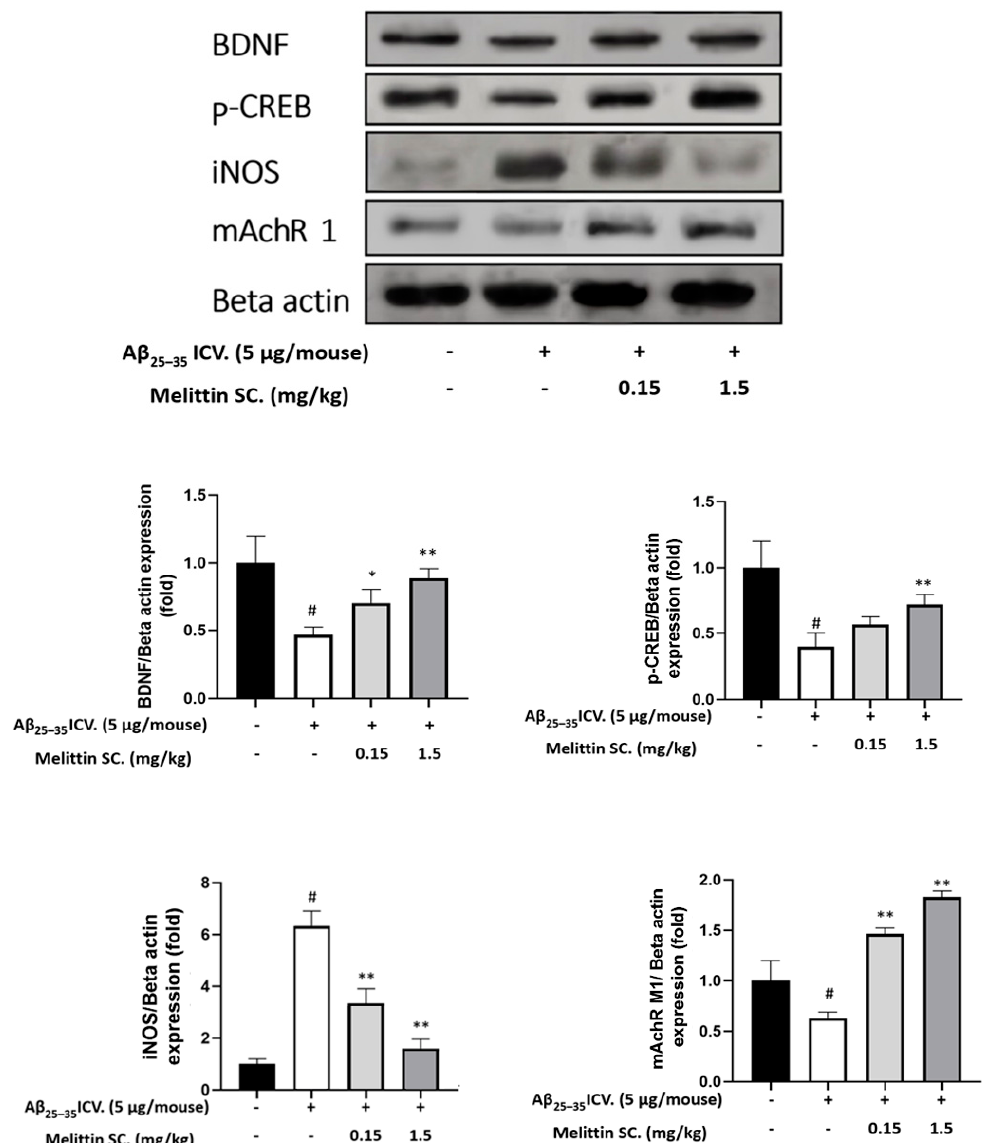
Figure 9. Levels of BDNF, p-CREB, iNOS, and mAchR1 protein expression in the mouse hippocampus show the dose- dependent protective effect of melittin against A β 25–35 -induced neuro-imbalance in vivo. To conduct this experiment: Western blot experiment was performed on protein extracts obtained from hippocampus tissue as described in the materials and methods section. Data are presented as the mean ± standard error values of the sextuple determinations. # p < 0.01 vs. control * p < 0.05 and ** p < 0.01 vs. A β 25–35 only-treated group.